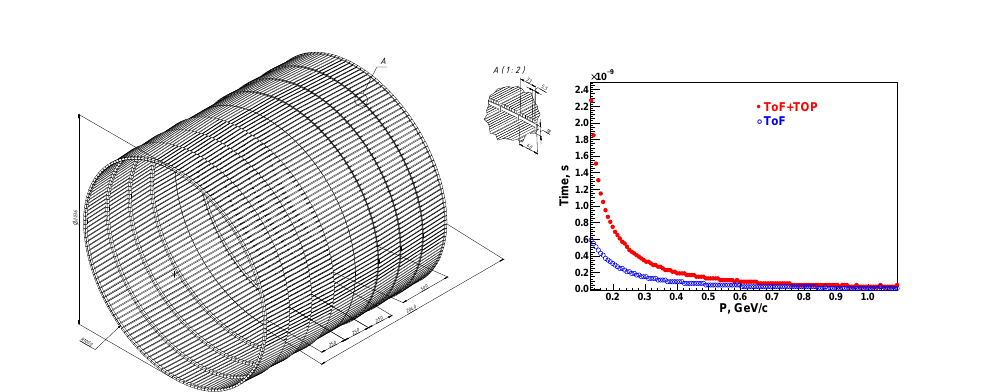
Figure 11. The dependence of time di ff erence be- tween muons and pions on momemtum: ToF ap- proach (open circles), ToF + TOP approach (solid